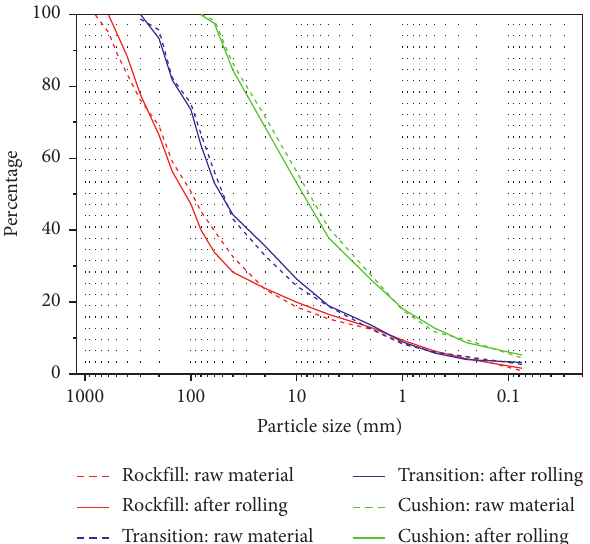
Figure 3: Particle gradation curve of compaction test.